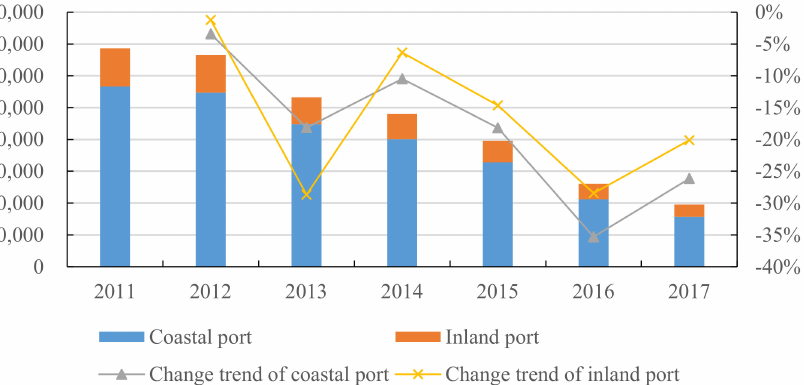
Figure 2. NO X emission of inland and coastal port (unit: ton). Note: The 2014 NO X emission data of coastal and ocean-going ships and inland ships in the Air Pollutant Emission Inventory of Marine in China (2017) calculate their proportion in China’s NO X emission in 2014 as a fixed proportion value from 2011 to 2017; then, by multiplying the fixed proportion value according to the NO X emission data in the China Statistical Yearbook and Statistical Yearbooks of each province, the NO X emission data of each port can be